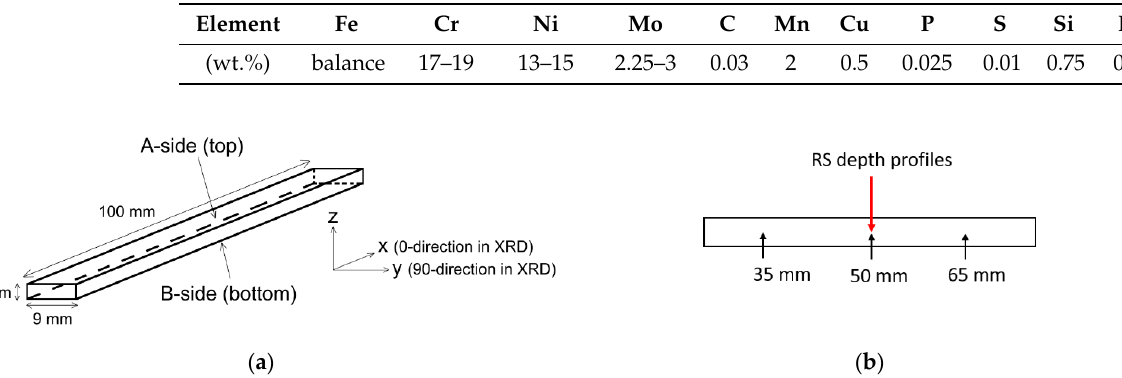
Figure 1. ( a ) Additive manufacturing (AM) strip sample geometry from 316L stainless-steel. ( b ) Locations of residual stress measurements from top and bottom sides (35, 50 and 65 mm from other end) and residual stress depth profiles from middle of sample (50 mm).